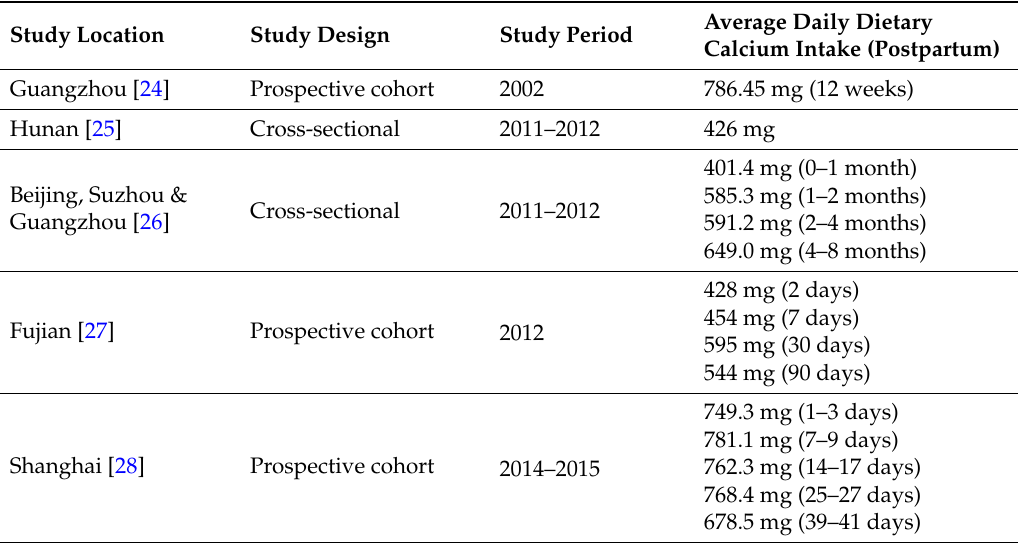
Table 1. Dietary calcium intake of lactating women in different regions of